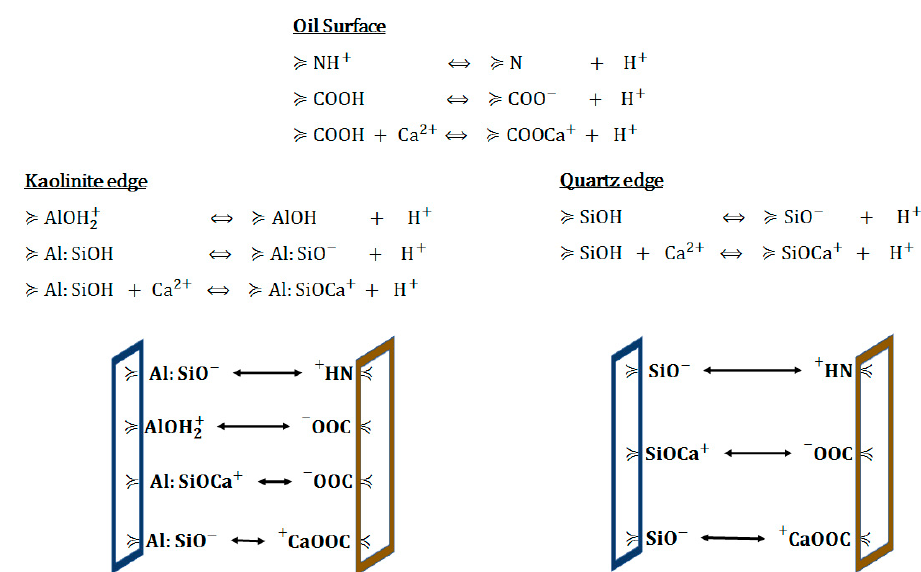
Figure 4. Possible oil-clay electrostatic attraction bridges that can influence oil adhesion onto the clay surface based on surface complexation reactions at the oil surface site ( top ), kaolinite edge ( middle left ) and quartz edge ( middle right ) (adapted from Brady et al. [179]).